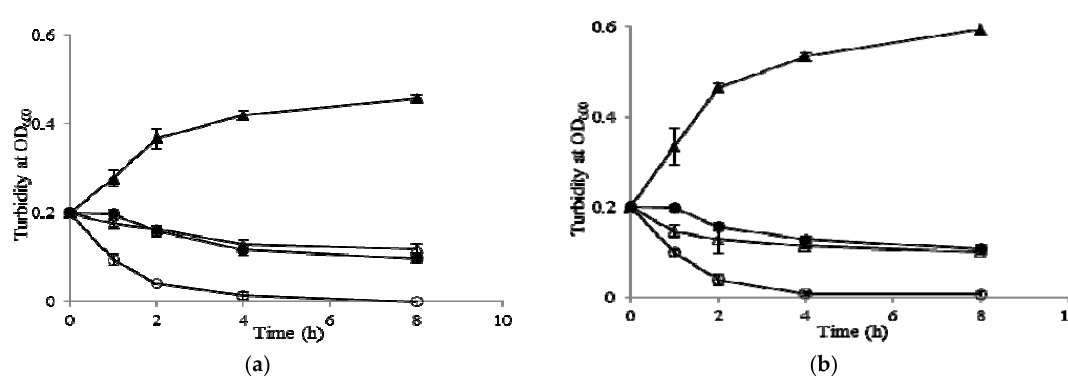
Figure 4. Bacterial growth kinetics of BCN E 50-52 and thymol at 2× MIC against E. coli and S. aureus . ( a ) E. coli; control (filled triangles), BCN E 50-52 512 µg/mL (filled circles), thymol 256 µg/mL (open triangles), BCN E 50-52 512 µg/mL and thymol 256 µg/mL (open circles); ( b ) S. aureus ; control (filled triangles), BCN E 50-52 512 µg/mL (filled circles), thymol 256 µg/mL (open triangles), BCN E 50-52 512 µg/mL and thymol 256 µg/mL (open circles). OD: optical density.